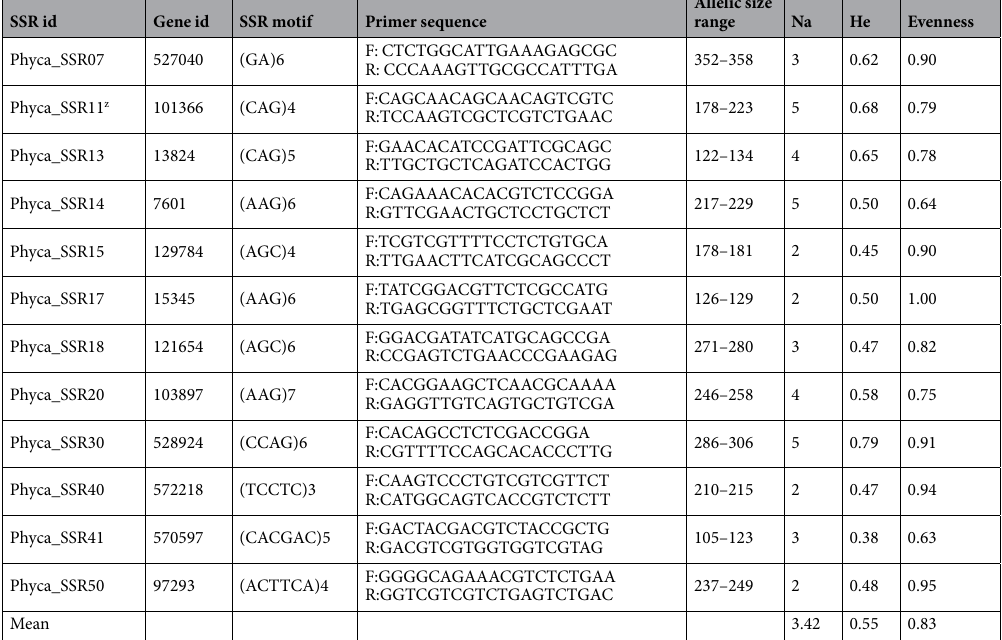
Table 3. Genetic diversity statistics for 12 microsatellite loci confirmed in 50 P. capsici isolates. Na: Number of alleles. He: Nei (1978) gene diversity. Evenness is a measure of the distribution of Multilocus Genotypes (MLGs) within the isolates (Pielou, 1975; Grünwald et al . 71 ).